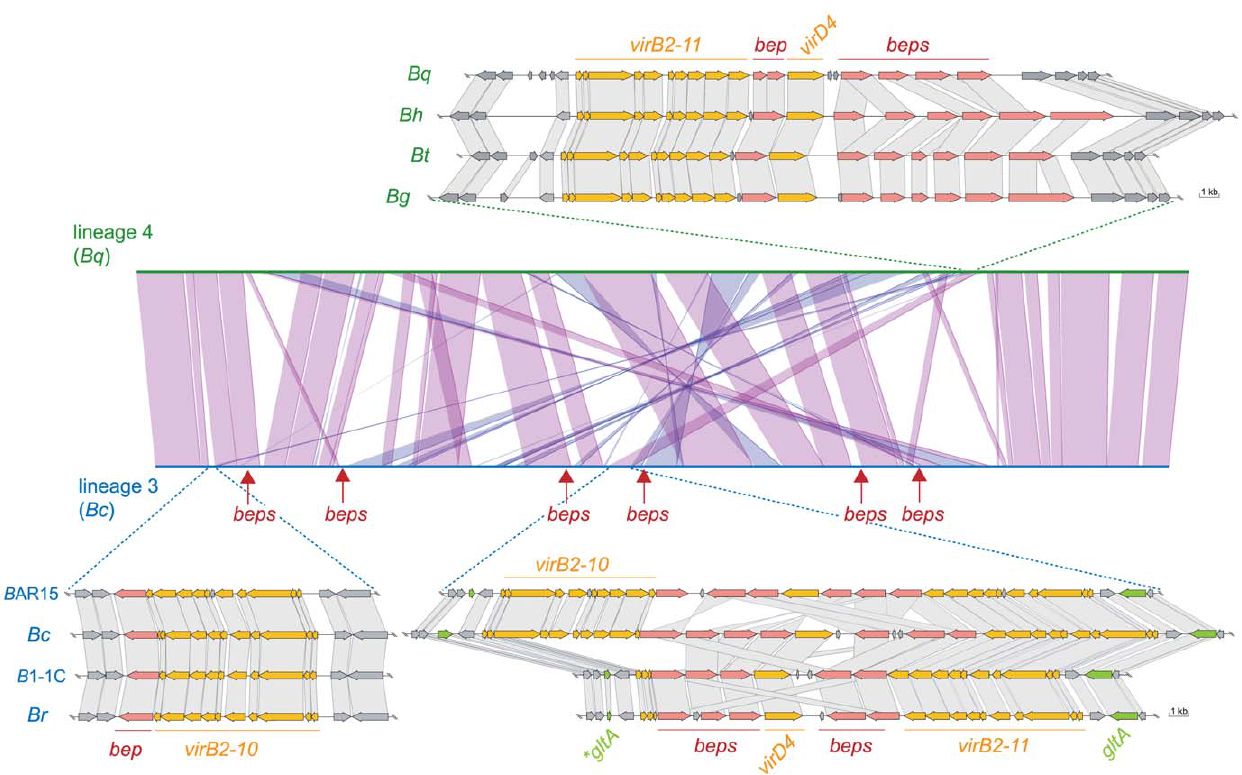
Figure 3. Genomic organization of the virB T4SS and bep gene loci in the two radiating lineages. Synteny plot of Bc (lineage 3) and Bq (lineage 4) generated in MaGe [58] and genetic organization of the virB T4SS loci. Syntenic relationships comprising at least five genes are indicated by violet and blue lines for genes found on the same or the opposite strand, respectively. The genomic integration sites of virB loci are indicated. Additional bep loci in lineage 3 are marked by arrows. For the depicted genomic loci, orthologous genes are connected via gray boxes. For bep genes, connections are drawn if they belong to the same Bep clade (Figure 4) or if they are top blast hits of one another. The glutamine syntethase I gene ( glnA ) and its fragments which are flanking the two inverted virB T4SS copies are colored in green. The fragments are indicated by an